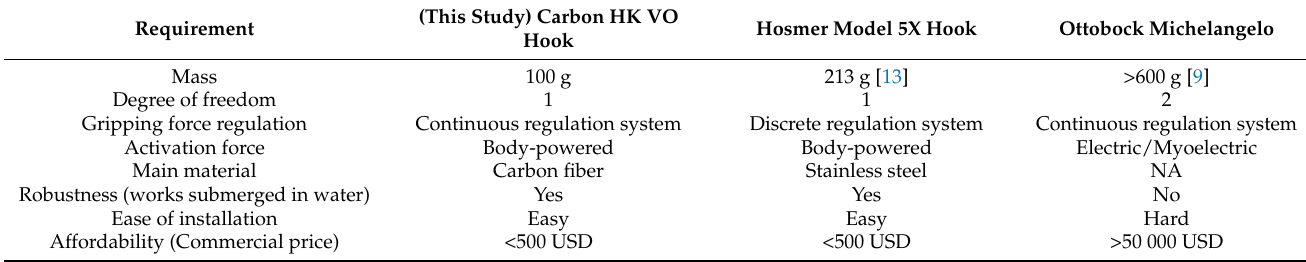
Table 2. Specifications of the Carbon HK VO Hook compared to current available upper limbs prosthetic.